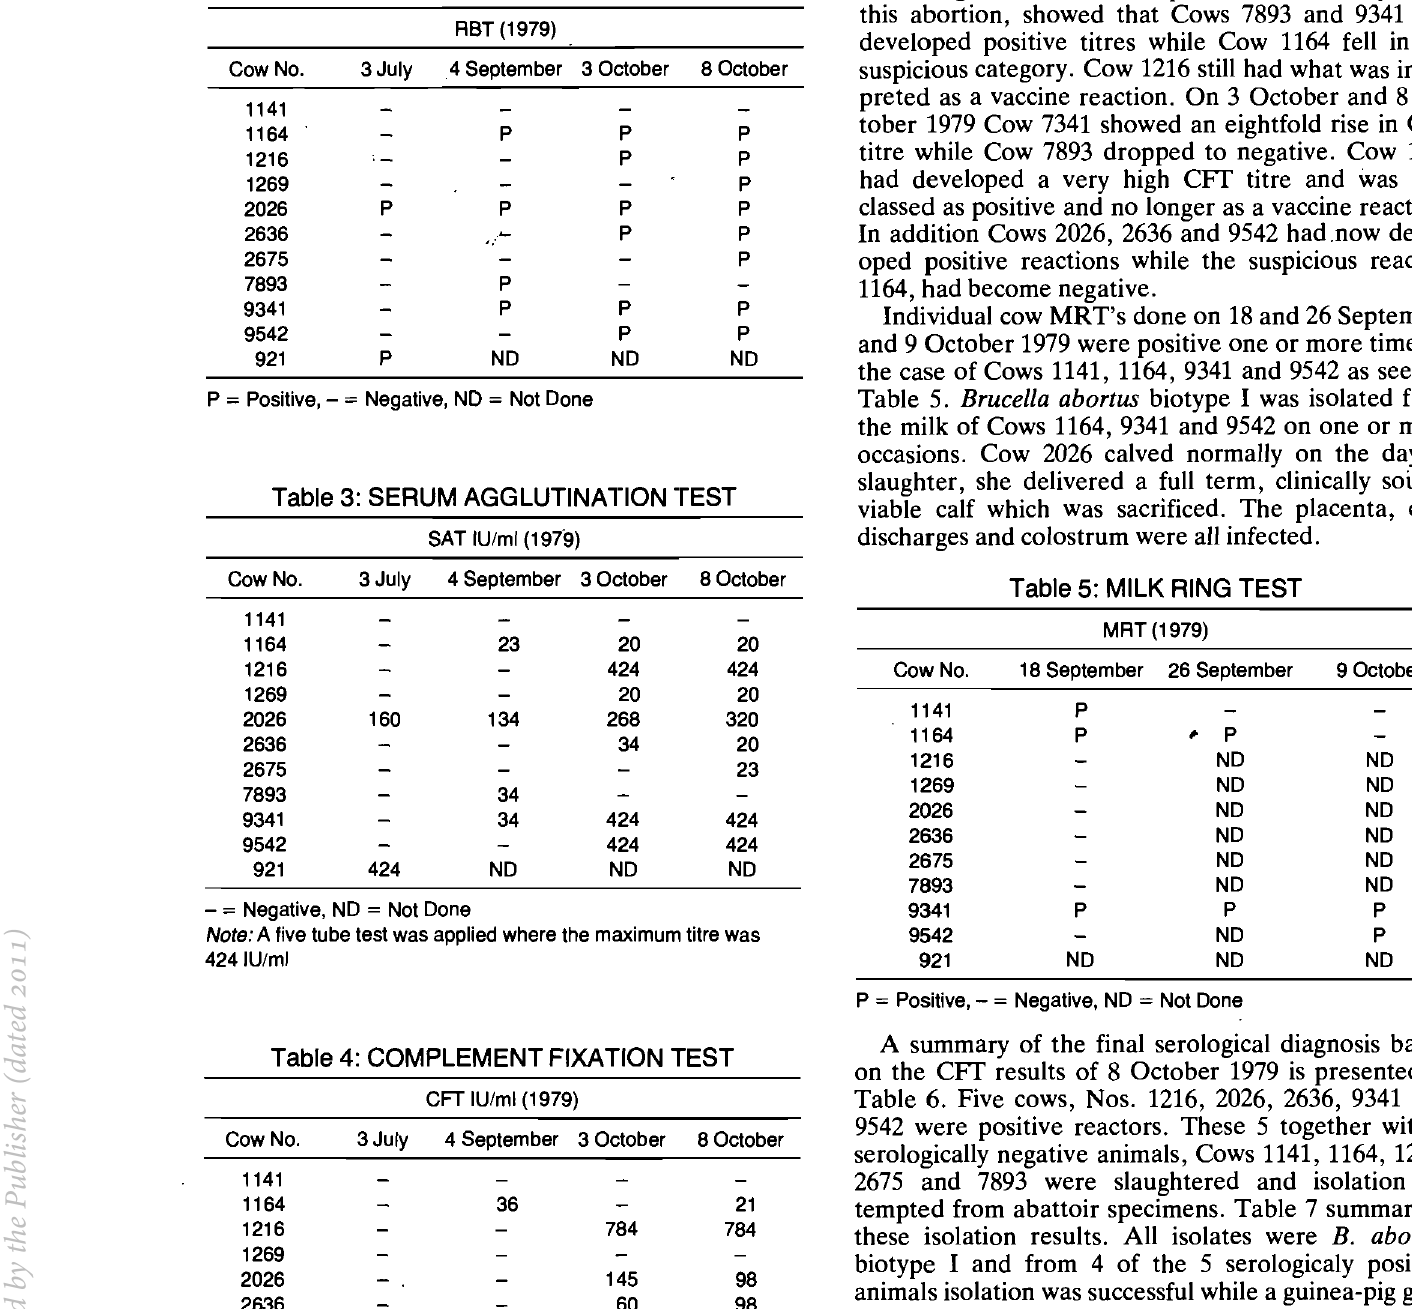
Table 6: SEROLOGICAL